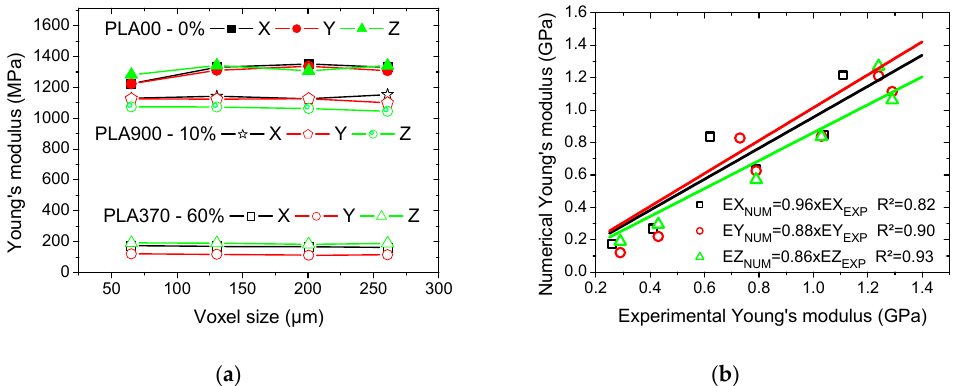
Figure 8. Predicted finite element results: ( a ) predicted Young’s modulus as a function of voxel size in all loading directions for various 3D printed PLA cellular structures, ( b ) comparison between predicted and experimental Young’s modulus for all 3D printed PLA cellular structures.